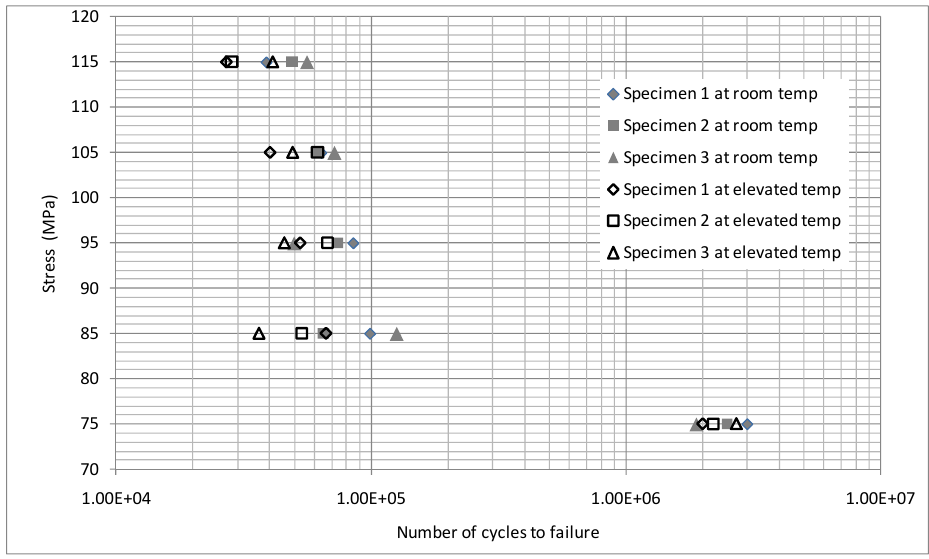
Figure 28. Fatigue life results at room and elevated temperature [17].